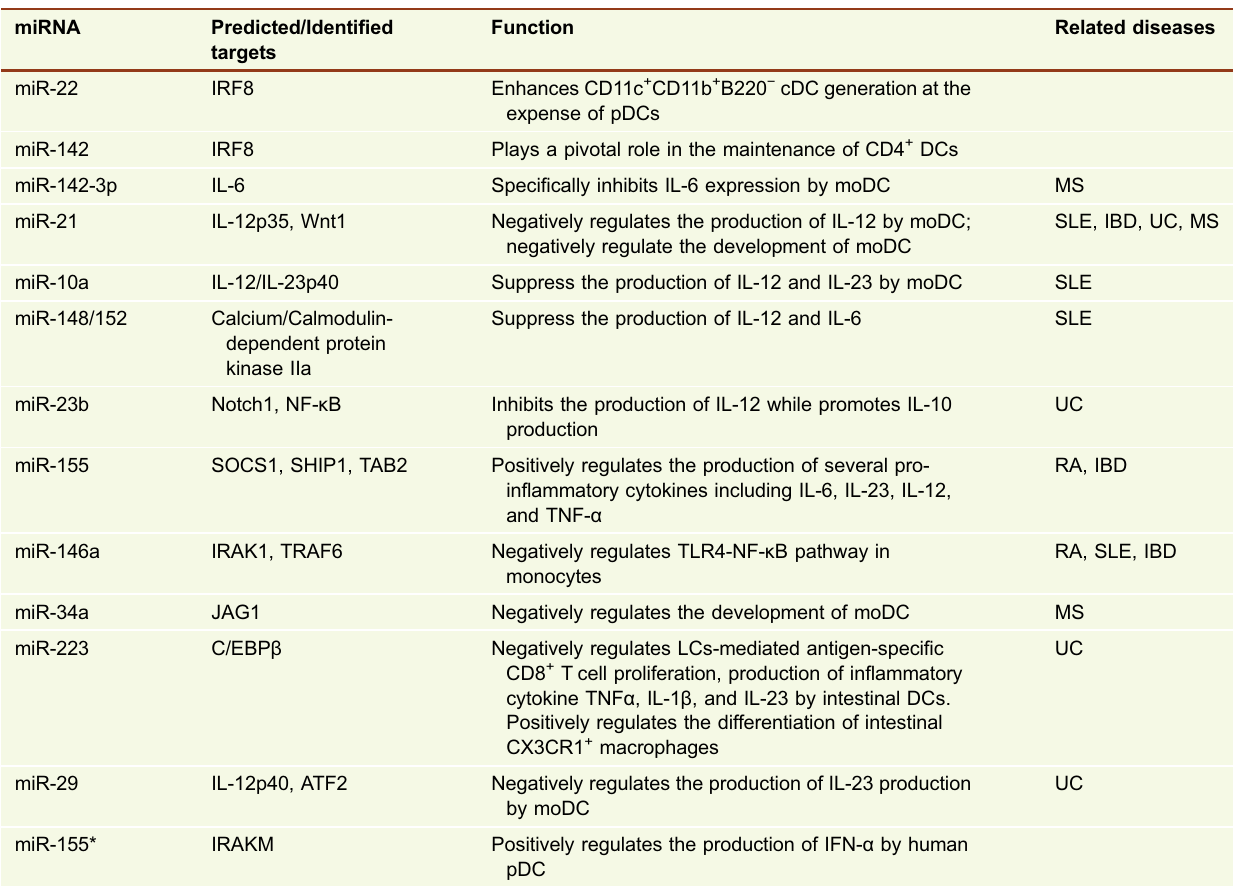
Table 1. The role of miRNAs in autoimmune diseases miRNA Predicted/Identi fi